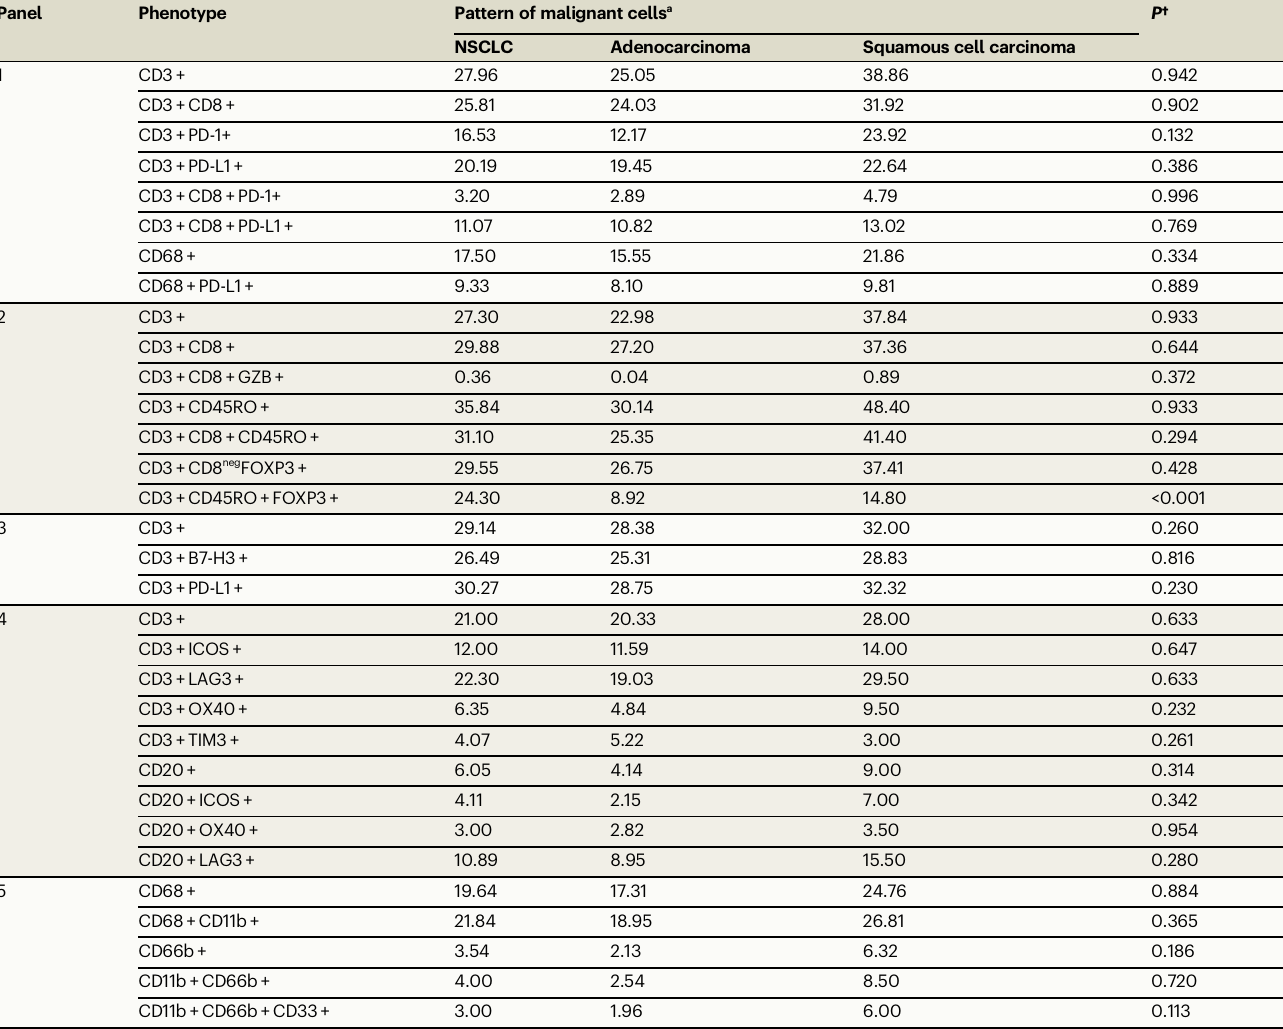
Table 1 | Patterns of cellular distribution according to histologic type ( n = 225) Panel